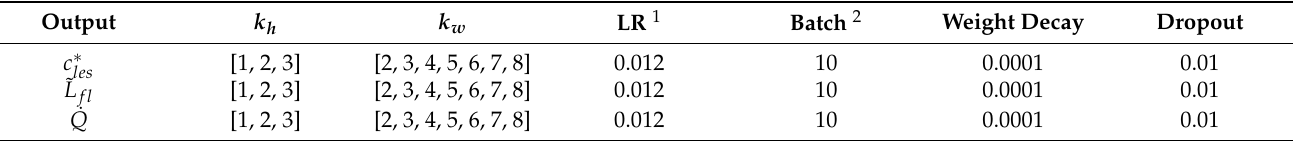
Table 2. Summary of surveyed MLPs architecture for each of the global quantities presented.